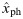
Snyder inter-event intensity estimate for the interrupted model when all photon times are known.The solution x^ph decays more rapidly relative to the switch time 1k as the mean number of photons per on state of the light model, β increases. The solution stays close to state 1 with increasing β, relative to the time to the next photon 2α. This indicates increased certainty as there is more information available.